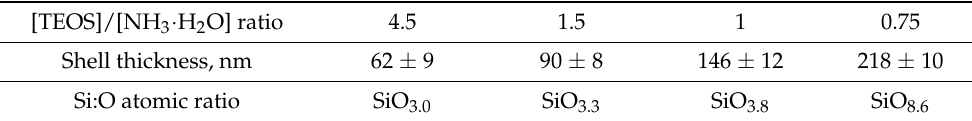
Figure 8. SEM images of core–shell particles obtained in the process with [TEOS]/[NH 3 ·H 2 O] = 0.75 ammonia concentration. Table 2. The mean thickness with the confidence interval ( p = 0.9) of the silica shell, measured from the ammonia concentration